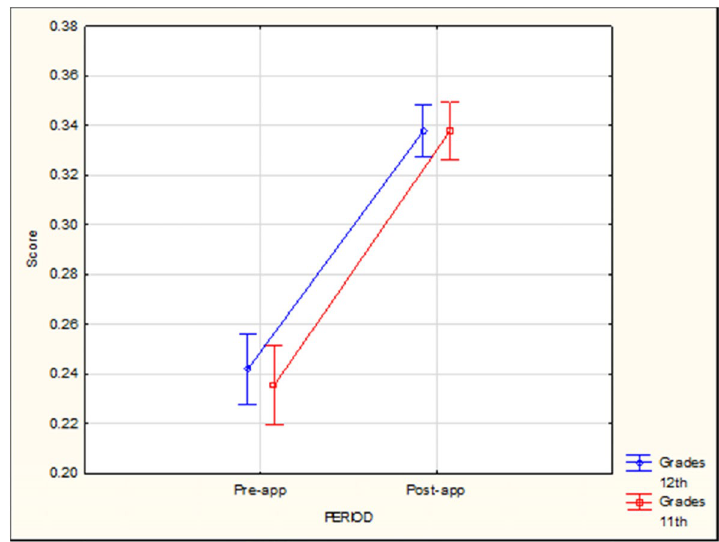
Fig. 2 Multifactorial dispersive analysis of the scores (factors: grades,